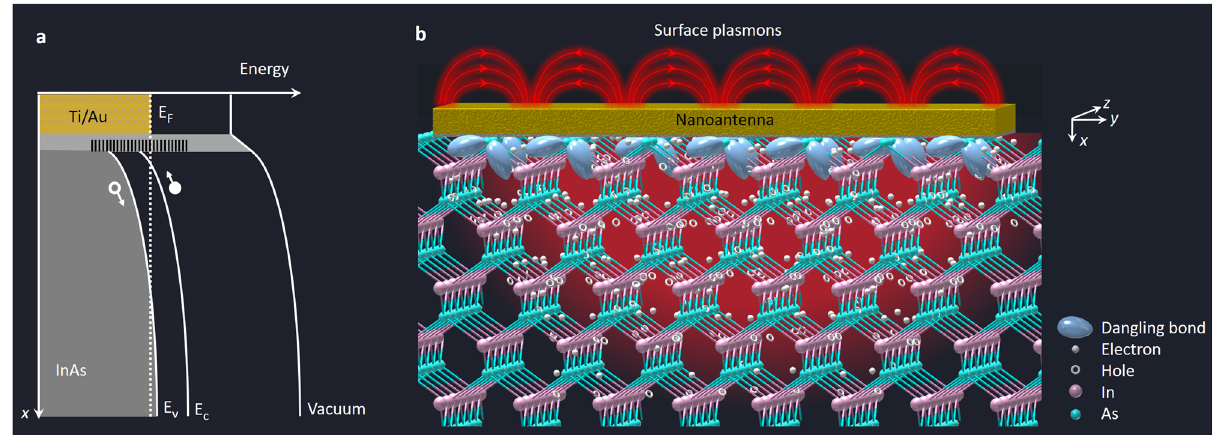
Fig. 1 Energy band bending caused by the InAs surface states. a Energy band diagram of a highly p-doped InAs substrate in contact with Ti/Au. The energy level at which the surface state density of the InAs peaks is located above its direct bandgap because there is a large difference between the direct (0.36 eV) and indirect bandgap energies (1.21 eV) of InAs. Electrons in these surface states recombine with the holes in the valence band and occupy a part of the conduction band to minimize their total energy. As a result, the Fermi energy level ( E F ) is pinned above the conduction band minimum ( E c ). Free electrons in the conduction band then migrate to the p-doped InAs layer to minimize their energy further, resulting in a steep band bending and a giant built-in electric fi eld induced at the InAs surface. b Schematic of the InAs lattice in contact with a nanoantenna that couples photo-excited surface plasmons to the surface